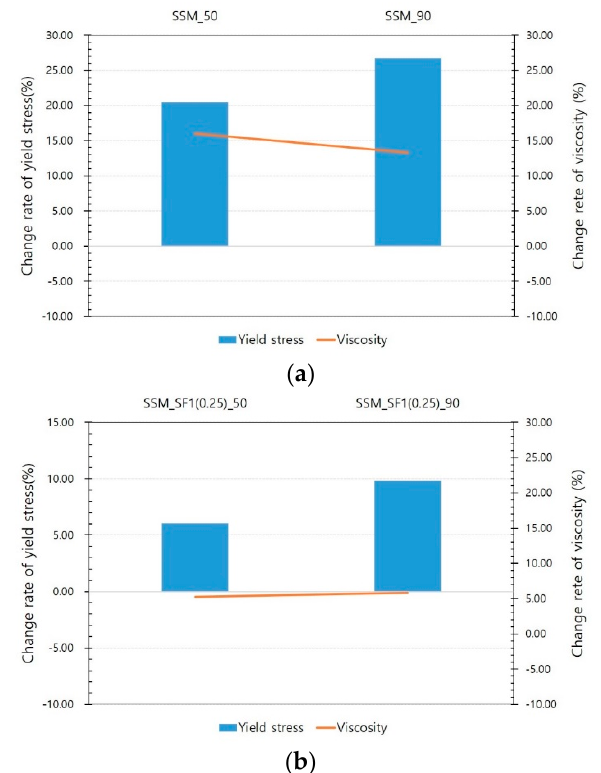
Figure 11. Results of SSM according to applied voltage: ( a ) SSM, ( b ) SSM_SF1(0.25).